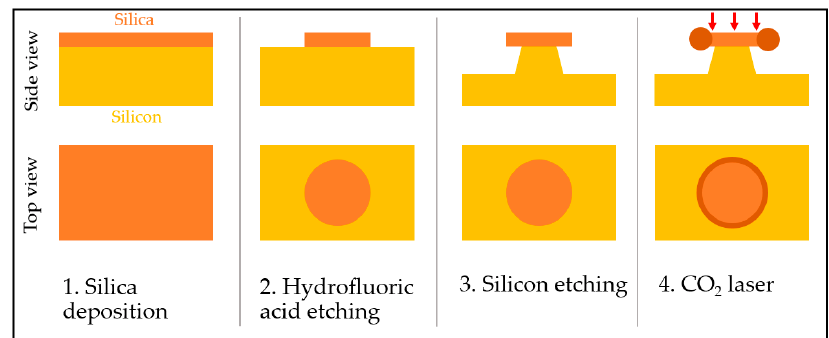
Figure 8. Microtoroid resonator fabrication process. ( 1 ) SiO 2 is deposited on a silicon wafer; ( 2 ) Hydrofluoric acid etching is applied to create the disk structure on top of the wafer; ( 3 ) XeF 2 etching is used to create a post structure; ( 4 ) CO 2 laser illuminates the structure to smoothen the toroid structure.